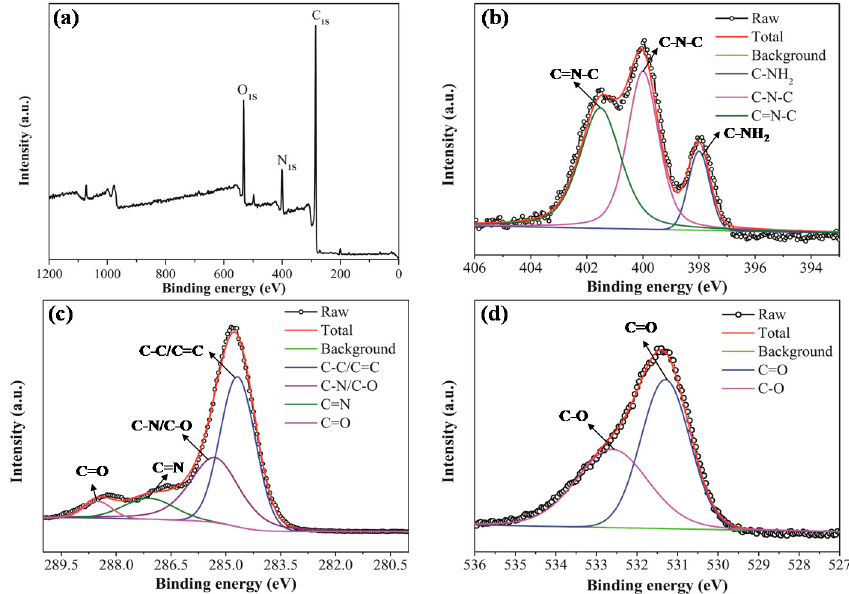
Figure 3. ( a ) XPS spectra and ( b ) N 1s , ( c ) C 1s , and ( d ) O 1s peaks of the as-prepared PCDs.